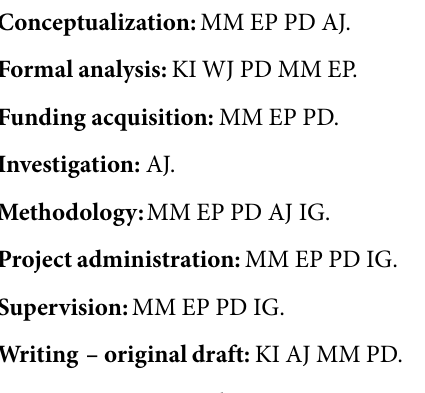
S1 Fig. Changes in mean (+/- SEM) (a) Affective Grid Activation score and (b) PANAS NA score across the study in Pleasant Room (solid line) and Unpleasant Room (dashed line)